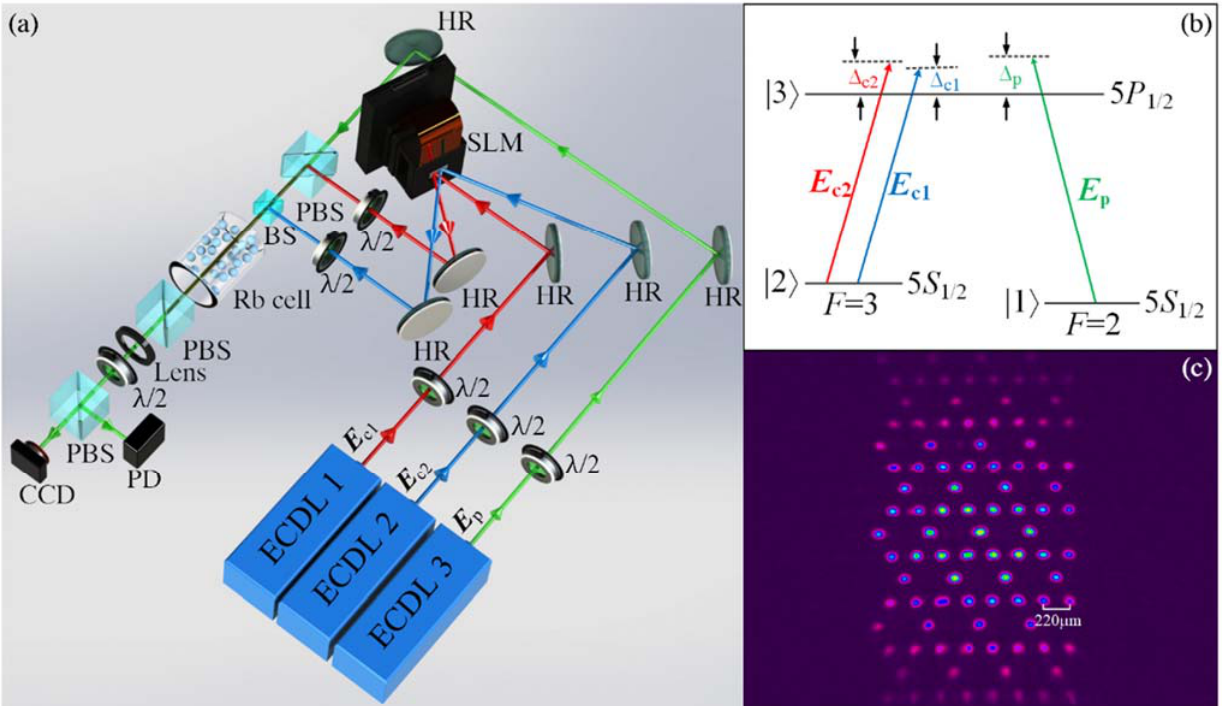
Figure 1. ( a ) Experimental setup. The coupling beam E c1 from ECDL1 is modulated into a Kagome intensity distribution by a SLM. The other coupling beam, E c2 from ECDL2, is transformed into a one-dimensional periodic field by the same SLM. The probe field E p from ECDL3 co-propagates with two coupling fields, and its output pattern is imaged onto the CCD camera through an imaging lens. The spot size of the used beams is ~ 3.5 mm. The powers of E c1 , E c2 , and E p are 20 mW, 10 mW, and 1 mW, respectively. The divergence angles of the beams from the adopted ECDLs in the x and y directions are ~0.89 mrad and ~1.81 mrad, respectively. ECDL: external cavity diode laser; λ /2: half-wave plate; HR: high-reflectivity mirror; SLM: spatial light modulator; PBS: polarization beam splitter; BS: beam splitter; and PD: photodiode detector. CCD: charge-coupled device. ( b ) The three-level Λ -type 85 Rb atomic structure. ( c ) The observed transmitted probe pattern with only the Kagome coupling field turned